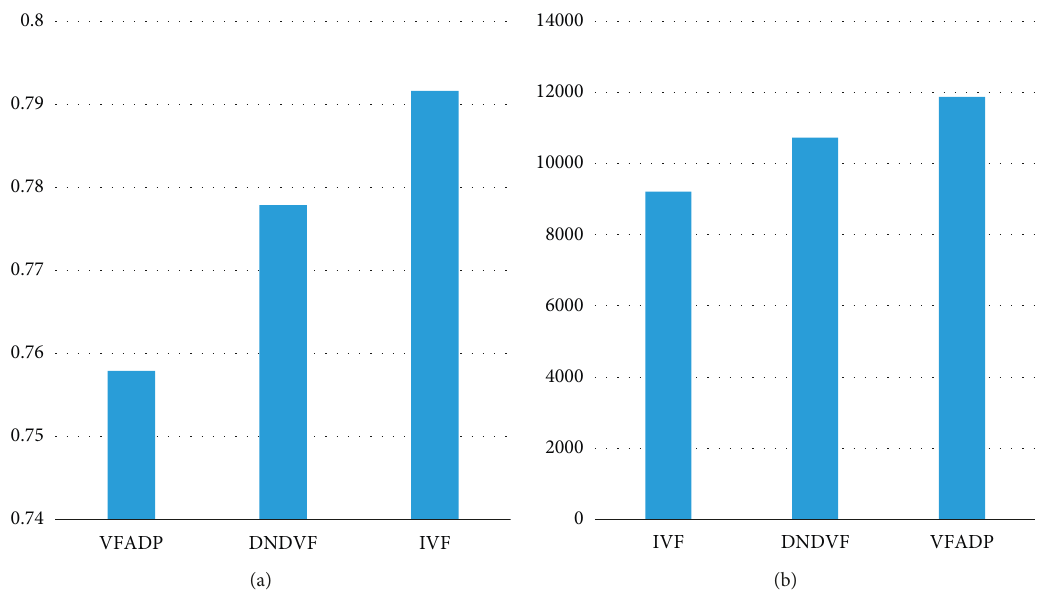
Figure 7: Coverage effect and moving distance in different algorithms when N � 100. (a) Coverage effect. (b) Moving distance